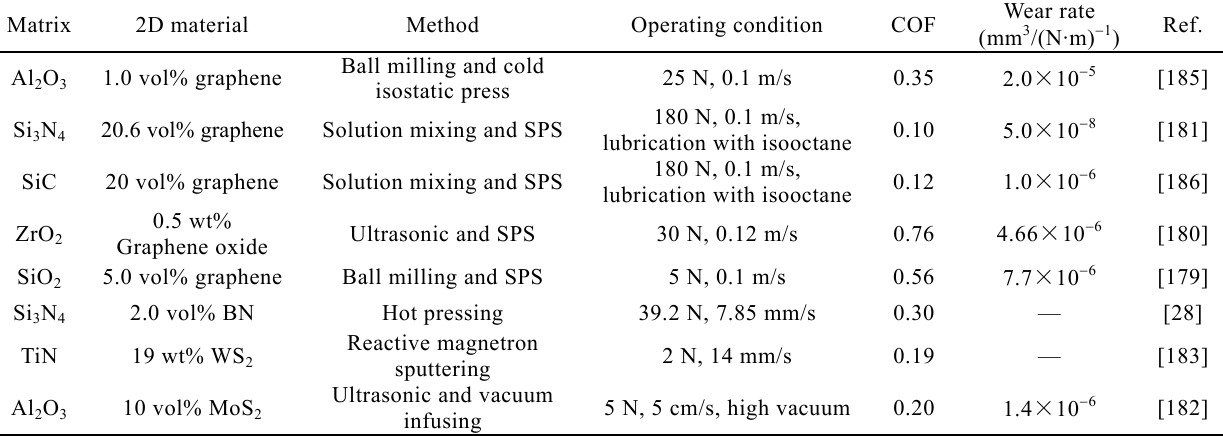
Table 5 Tribological properties of ceramic composites reinforced with 2D materials. Matrix 2D material